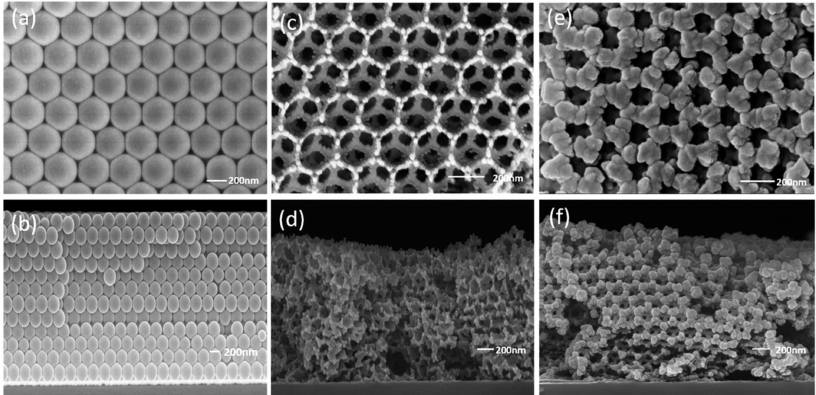
Figure 31. SEM images of ( a , b ) PS template, ( c , d ) 3DOM NiFe 2 O 4 membrane and ( e , f ) 3DOM Al/NiFe 2 O 4 membrane after Al deposition, ( a , c , e ) surface view and ( b , d , f ) cross-section view. ( a – f ) Reproduced with the permission of ref. [150]. Copyright 2016, RSC